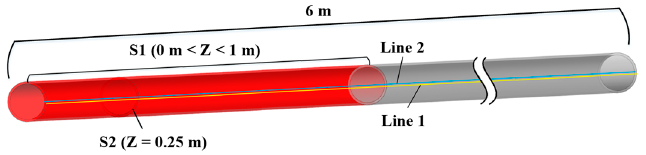
Figure 4. Schematic diagram of the specific faces and the lines on the target tube.